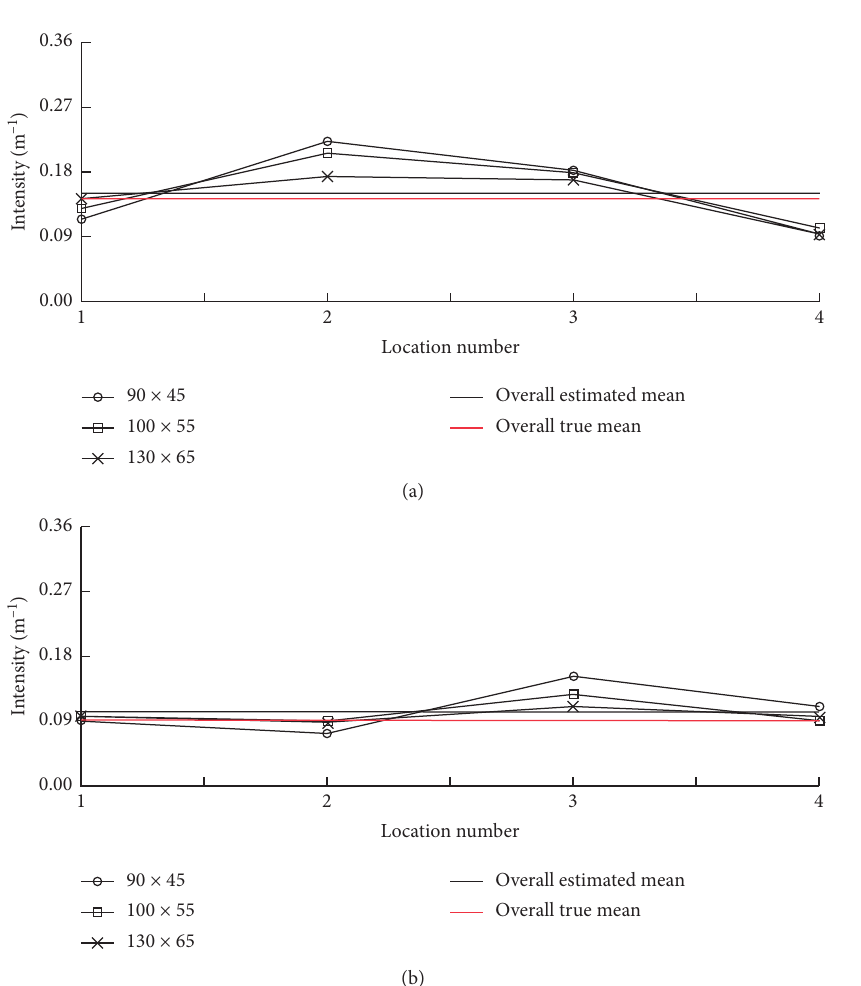
Figure 9: Estimated intensity based on new estimation method using rectangular windows of different sizes placed at different locations on the outcrop. (a) Set 1. (b) Set